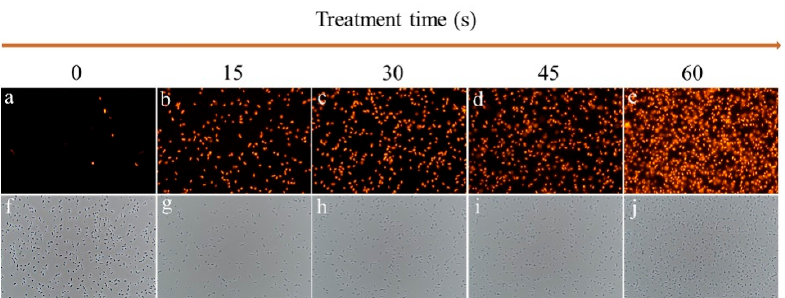
Figure 4. Changes in the membrane permeability of P. deceptionensis CM2 cells after SAEW treat- ment. Values marked with different letters are significantly different at p <0.05.